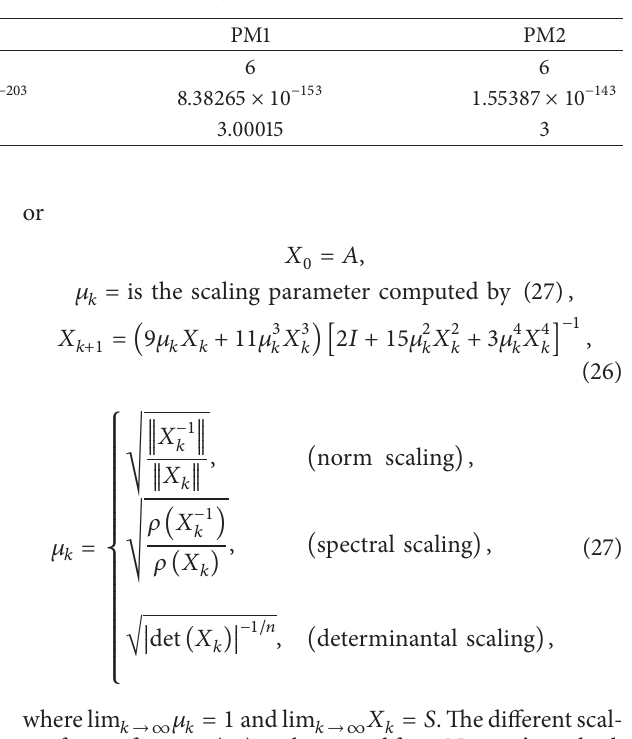
Table 2: Results of comparisons for Example 6 using 𝑋 0 = 𝐴